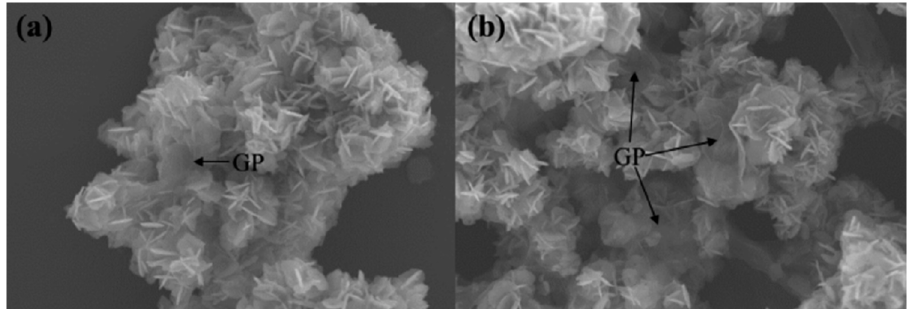
Figure 14. SEM images of TiO 2 /GO nanocomposites with different G loadings using magnification ×10,000. Reprinted with permission from reference [97]. Copyright 2014 Elsevier.